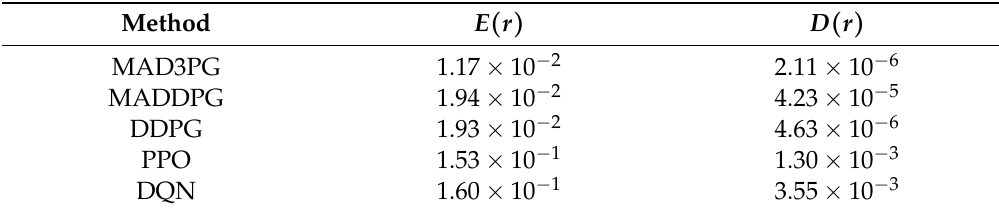
Table 4. Comparisons of the mean and variance of the rewards.